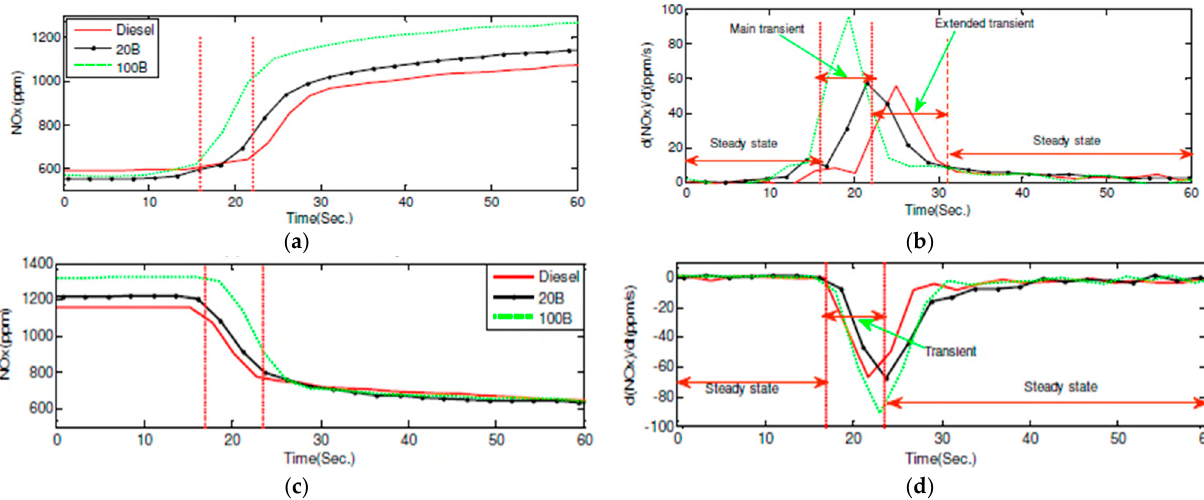
Figure 13. ( a ) CI engine’s NOx emission time variation running with the tested fuels during a positive speed transient; ( b ) equivalent rate of change of NOx emission during the positive speed transient. ( c ) Time variation of NOx emission during a negative torque transient; ( d ) corresponding rate of change NOx emission during negative torque transient.